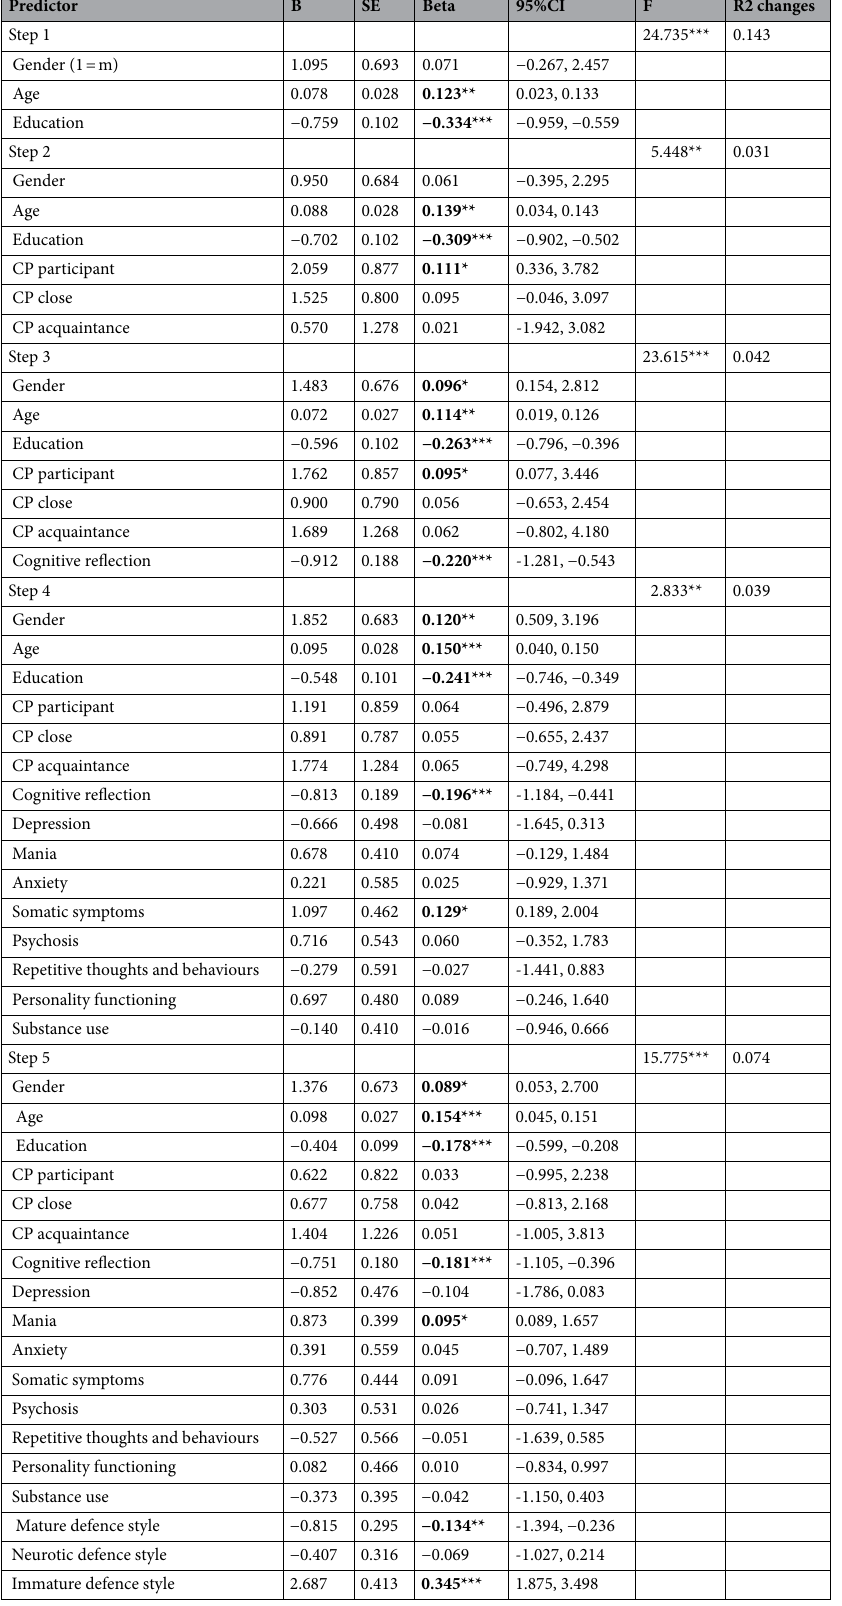
Table 3. Results of hierarchical regression analysis for COVID-19 related CT ( n = 447). Statistically significant predictors in bold. CP participant COVID-19 positivity participants, CP close COVID-19 positivity of someone close, CP acquaintance COVID-19 positivity of acquaintance. * p < 0.05; ** p < 0.01; *** p <